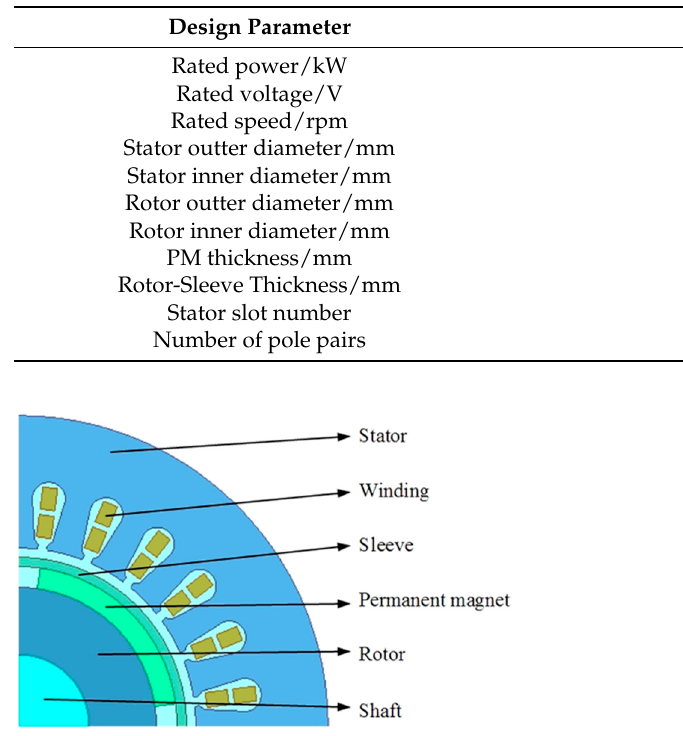
Table 1. Cryogenic permanent magnet brushless DC motor parameters.